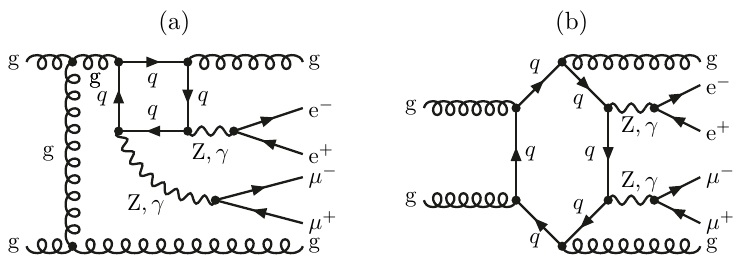
Figure 2. Sample diagrams for the loop-induced process gg → e + e − µ + µ −